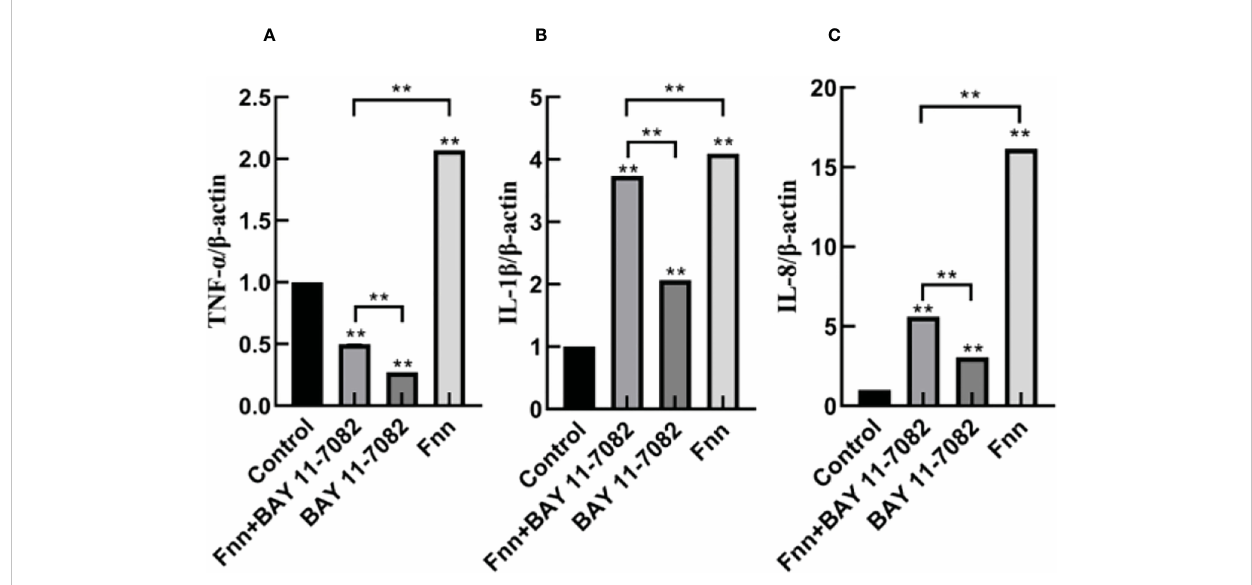
FIGURE 6 Effect of F. necrophorum infection on the mRNA expression of proin fl ammatory cytokines in intertoe skin explants. (A – C) show the mRNA expressions of TNF- a , IL-1 b , and IL-8, respectively. The data presented are the mean ± SD. *statistical signi fi cance (P < 0.05). **statistical signi fi cance (P < 0.01). The symbols * and ** indicate the signi fi cant differences with the control group.